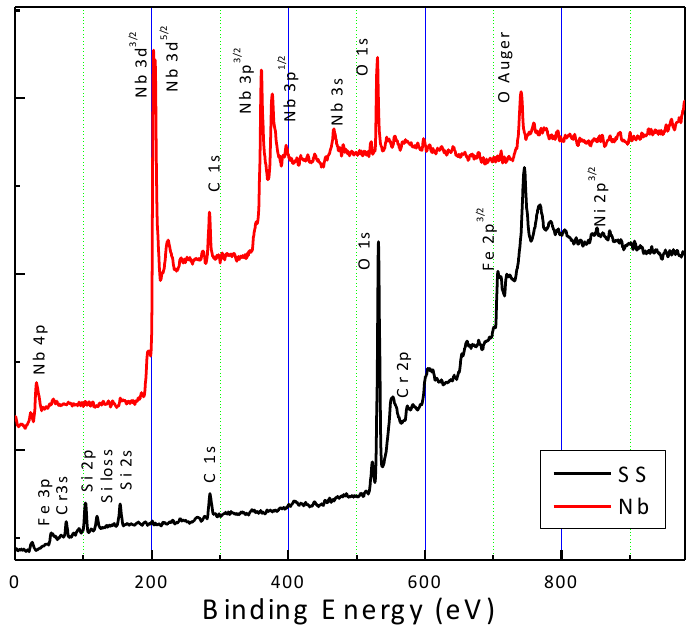
Figure 2. XPS spectra of the bare substrate and the Nb-coated steel. Binding energy of the Nb peaks appeared at: Nb 3d3/2 (202 eV), Nb 3d5/2 (205 eV), Nb 3p3/2 (360.6 eV) and Nb 3p1/2 (376.5